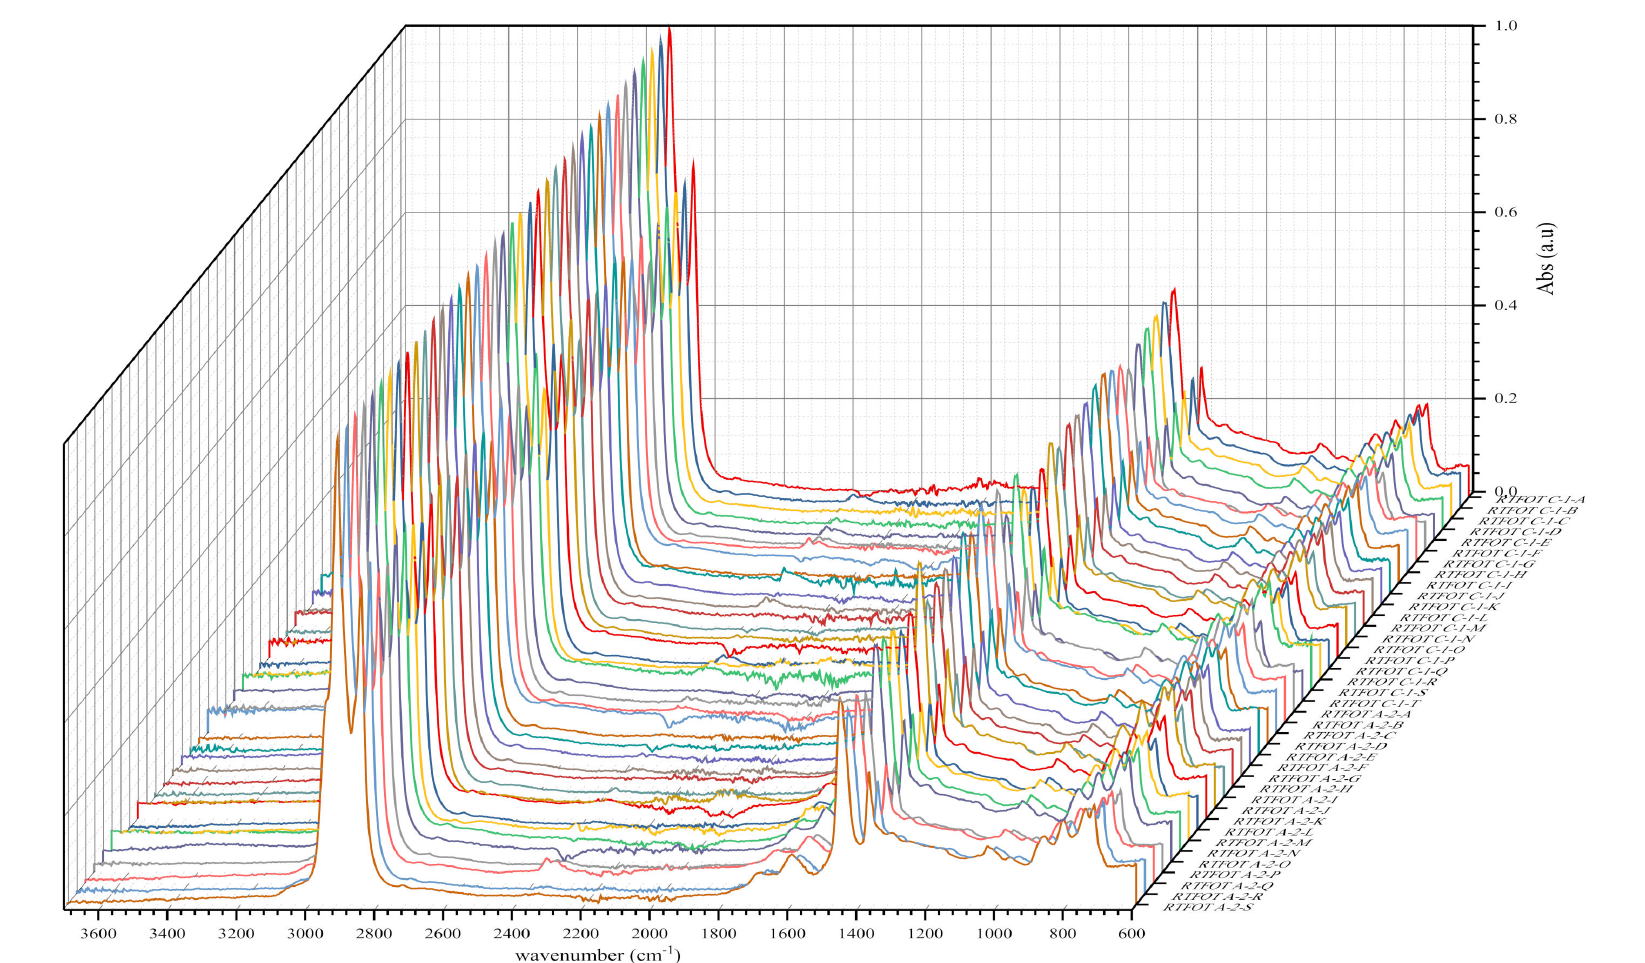
Figure 7. IR spectra of BND 100/130 from plants A and C after short-term ageing